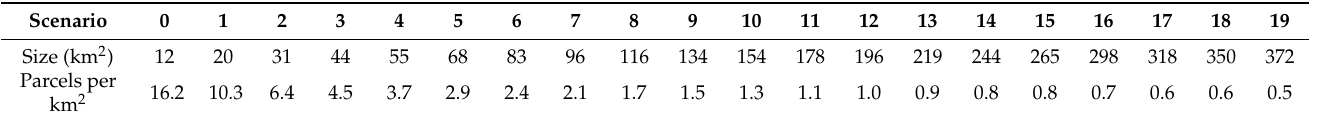
Table 2. Parcels in each operating